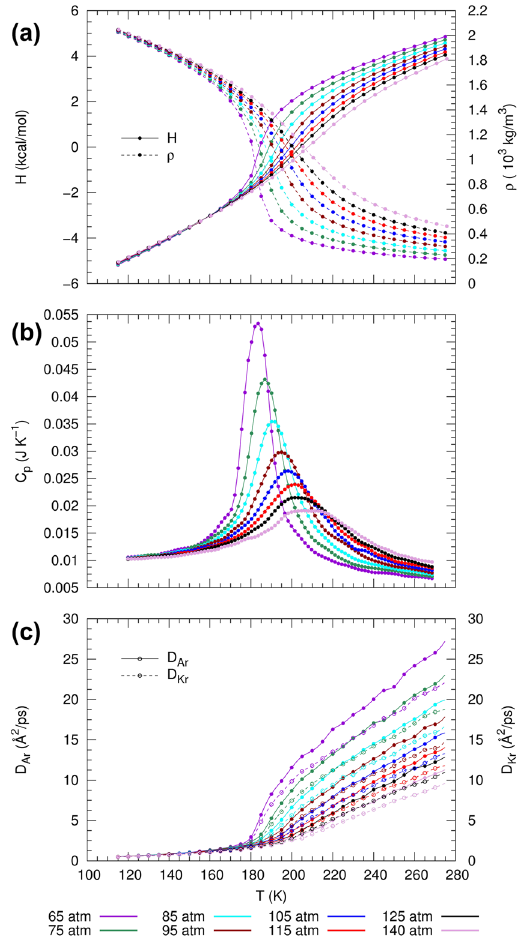
Figure 1. Thermophysical properties and response functions for equimolar Ar/Kr mixture with type-I phase behavior, showing supercritical isobars of ( a ) enthalpy H and density ρ , ( b ) isobaric heat capacity C p and ( c ) diffusion coefficients ( D Ar and D Kr ) as functions of